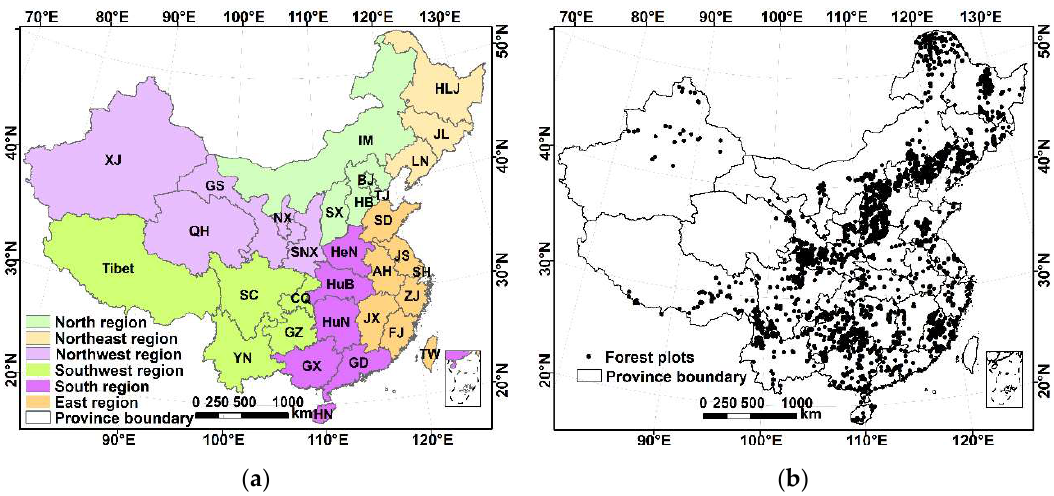
Figure 1. Distributions of forest regions and plots in China. ( a ) Forest regions following Fang et al. [42]; ( b ) geographical distribution of the 3543 forest plots used in this study. The northeastern region includes Liaoning (LN), Jilin (JL), and Heilongjiang (HLJ); the northern region includes Beijing (BJ), Tianjin (TJ), Hebei (HB), Shanxi (SX), and Inner Mongolia (IM); the eastern region includes Shanghai (SH), Jiangsu (JS), Zhejiang (ZJ), Anhui (AH), Fujian (FJ), Jiangxi (JX), and Shandong (SD); the southern region includes Henan (HeN), Hubei (HuB), Hunan (HuN), Guangdong (GD), Guangxi (GX), and Hainan (HN); the southwestern region includes Chongqing (CQ), Sichuan (SC), Guizhou (GZ), Yunnan (YN), and Tibet; the northwestern region includes Shannxi (SNX), Gansu (GS), Qinghai (QH), Ningxia (NX), and Xinjiang (XJ).